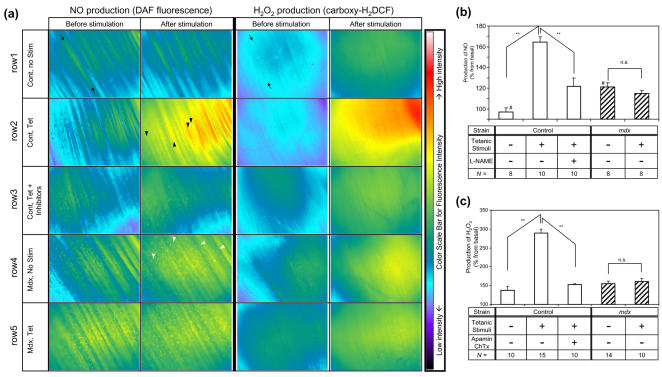

 In vivo microscopic measurement of muscle production of NO and H2O2 in control and mdx mice after tetanic stimulation.(a) In vivo microscopic views of fluorescent signal (100×) are presented with pseudocolors added according to the fluorescent intensity of the signals (a). Warmer colors correspond to higher intensity (note scale bar on right side). NO or H2O2 produced by stimulated myofibers reacts with DAF-FM (left column) or H2-DCFDA (right column) respectively, and releases a fluorescence signal. The longitudinal area between the two black arrows in the microscopic image corresponds to an individual myofiber (row1, Cont, no Stim). Myofibers in the control muscles produce a prominent amount of NO (left) and H2O2 (right) in response to tetanic stimuli (50Hz), shown as Cont, Tet (row 2). The spot-like staining showed an increased production of NO in response to muscle contraction (“Cont, Tet” in the left column, examples pointed by a black arrow head), but were not prominent with H2O2 signal (right column). A non-specific NOS inhibitor L-NAME (row3, left), or combination of EDHF inhibitors apamin and charybdotoxin (row 3, right), perturbed production of NO or H2O2, respectively, after tetanic stimulation (Cont, Tet+Inhibitors). Although the basal level of NO production in the mdx muscle is high (row 4, left column, Mdx, no Stim, p = 0.004 by Student-t test), muscles in these mice do not show an increase in the NO (row 5, left) or H2O2 (row 5, right) production in response to muscle contraction (Mdx, Tet). Mdx mice showed greater numbers of spot-like staining for NO (examples pointed by a white arrow head) as compared to control mice, but these spots did not show an increase in intensity after muscle contraction. (b&c) The quantification data of the detected signal of NO (b) and H2O2 (c) in the sternomastoid muscles are shown. Average fluorescence released by myocytes was calculated by densitometry of the captured images from in vivo microscopy on different mice (the numbers of animals in each group indicated in the bottom row). The y-axis represents the percent increase in the arbitrary fluorescence unit per 30 (b) or 60 (c) minutes of observation. **: Statistically significant by ANOVA (P<0.01). n.s.: Not statistically significant. #: Statistically significant between the basal level of control and mdx mice (P<0.05). Error bars show standard error of each value.